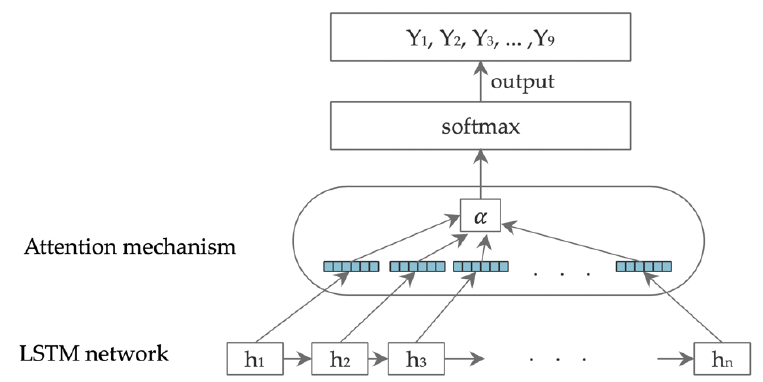
Figure 5. LSTM hidden layer to attention mechanism flow description.